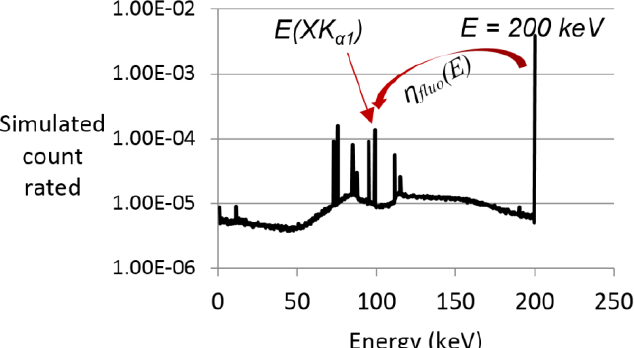
Fig. 1. Experimental spectrum of a 479 g ore sample with an uranium concentration of 419 ppm U and a density of 1.46 g.cm -3 with for 7503 seconds of acquisition